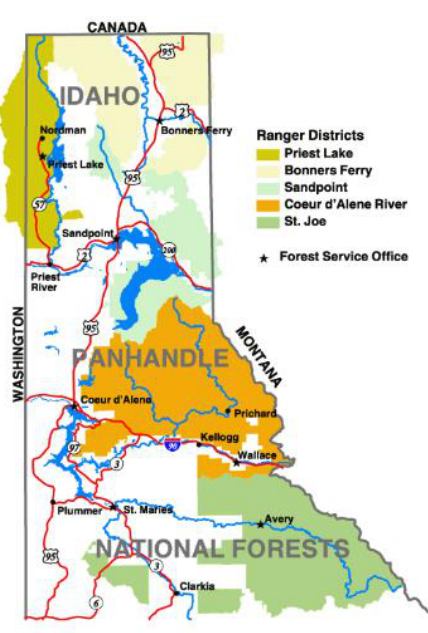
Figure 1 . Map of Canadian Forest Districts (Ralph 2005).